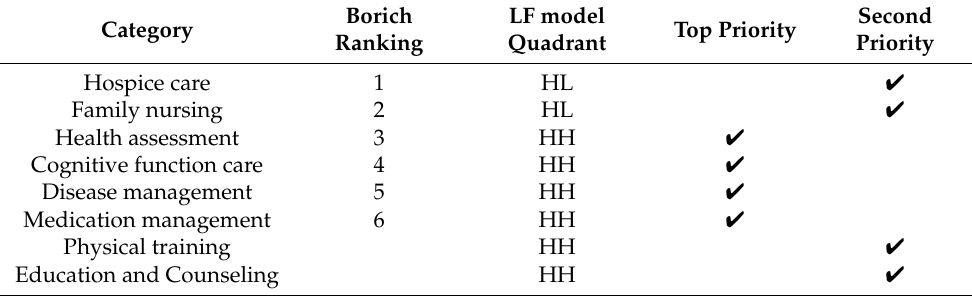
Table 3. Priority categories for educational needs ( N = 92).